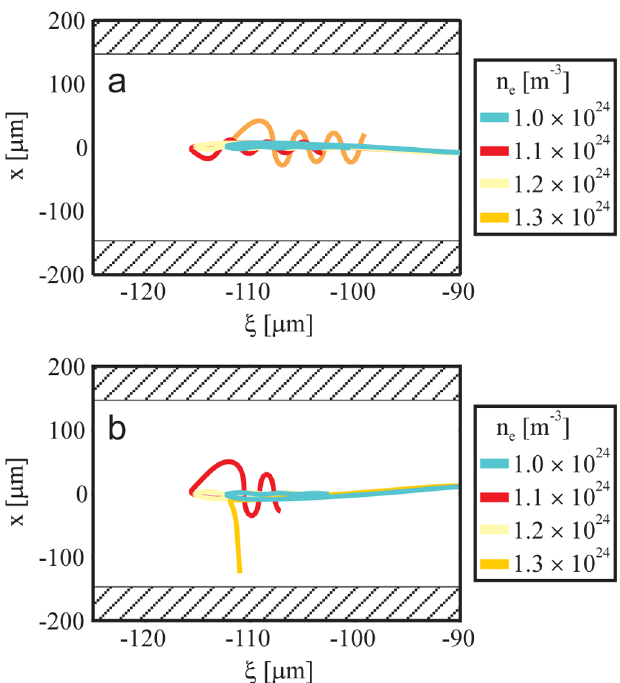
FIG. 14. (Color) Particle trajectories in the comoving coordinate (cid:3) [see Eq. (7)] for two different test particles for densities of 1 : 0 – 1 : 3 (cid:4) 10 24 m (cid:3) 3 illustrating the difference in betatron oscil- lations. Fluctuations in density can lead to both increased beta- tron oscillations (a) and can even lead to additional loss of electrons as the betatron oscillations expel them beyond the radius where they are still trapped